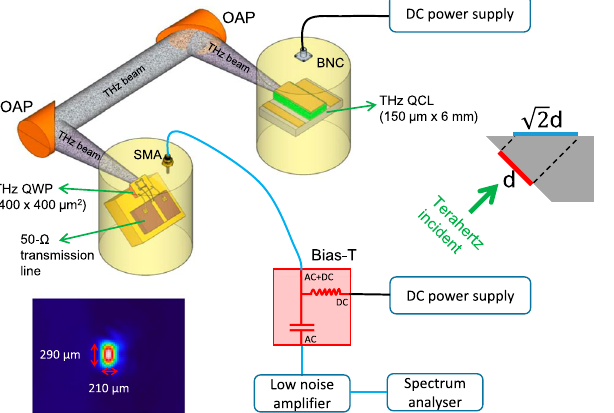
Figure 1. Experimental setup of the fast terahertz detection using a microwave transmission line equipped terahertz QWP. The modulated terahertz light is generated from a 6-mm long cavity terahertz QCL working in continuous wave mode. Two off-axis parabolic (OAP) mirrors are used for light collection and collimation. The lower left inset shows the two-dimensional focused beam pattern of the terahertz QCL measured using a terahertz imager. The upper right inset is the schematic of the terahertz light incident on the QWP chip. d is the diameter of the terahertz beam and d 2 the side dimension of the QWP chip to ideally absorb the terahertz radiation. SMA: SubMiniature version A, BNC: Bayonet Neil